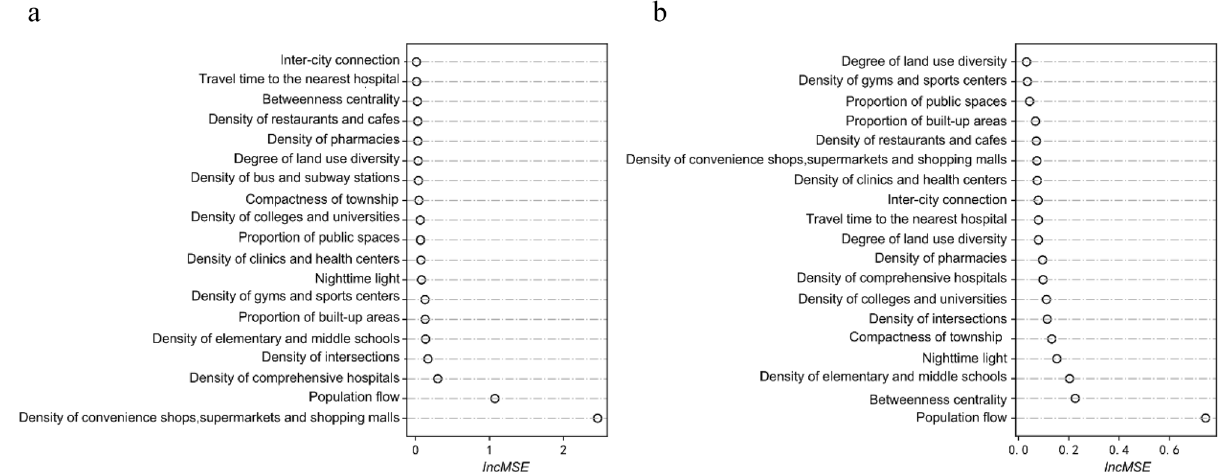
Figure 2. Importance of built environment factors in the spread of COVID-19. ( a ) Relative importance of built environment factors to RCIC. ( b ) Relative importance of built environment factors to CVIC. Created using Anaconda Navigator Version 1.9.12 from Anaconda (https:// www. anaco nda.